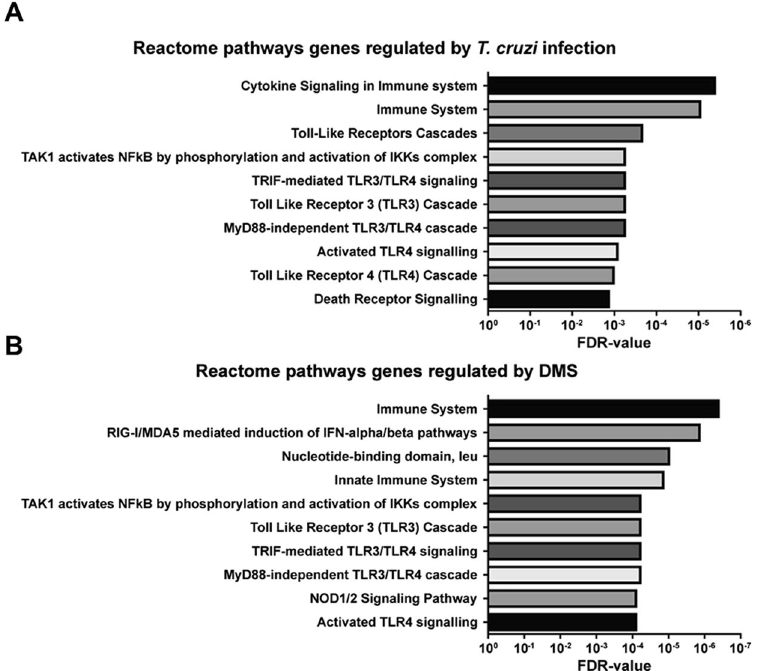
Figure 8. Reactome pathway analysis of DEG by T cruzi infection or DMS treatment. ( A ) Graph representing the 10 most significant pathways in which common DEG by T. cruzi at 25 h (Tc 1 h condition) and 48 h (Tc 24 h condition) after infection are involved. ( B ) Graph representing the 10 most significant pathways in which genes induced by DMS treatment are